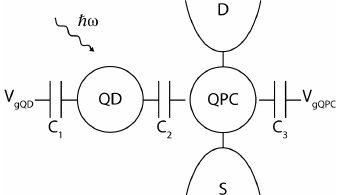
Figure 2. Capacitively coupled systems made by two quantum dots (QDs)—or a QD and a quantum point contact (QPC)—are used to detect photon absorption events. In this scheme, the two systems are individually tuned by external gates. The left dot works as the absorber, the second device is tuned in a configuration where its conductance is strongly dependent on the electrostatic environment. The transition induced by the absorption of the photon results in a conductance change for the sensing (QPC)